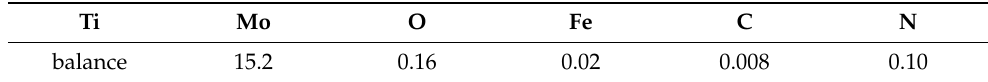
Table 1. Chemical composition of the studied alloy (wt%). Ti Mo O